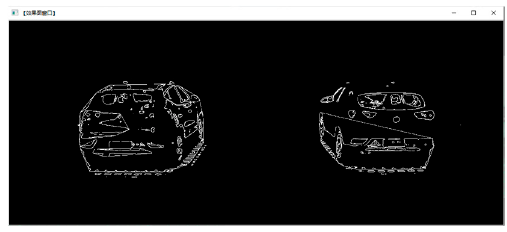
Figure 19. The contour of the laser grid.